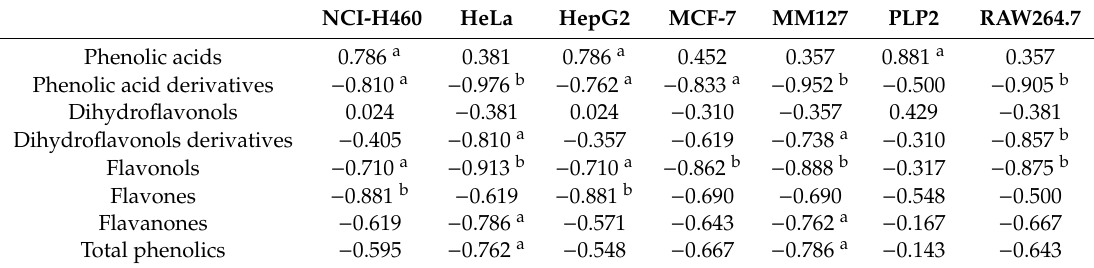
Table 2. Spearman’s correlations between the propolis phenolic composition (mg / g of extract) and cytotoxicity and anti-inflammatory activity GI 50 / IC 50 values ( µ g /